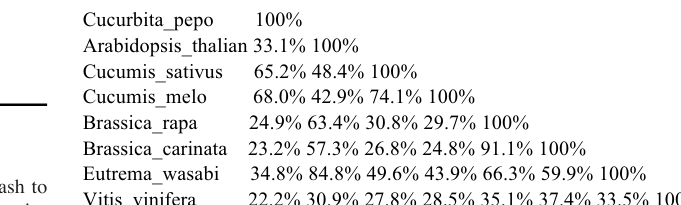
Fig. 1: Mean comparison of treatments in induced resistance of squash to powdery mildew (Duncan test, P < 1%). Different letters show sig- nificant differences. Standard error (SE) bars are presented for each sample.